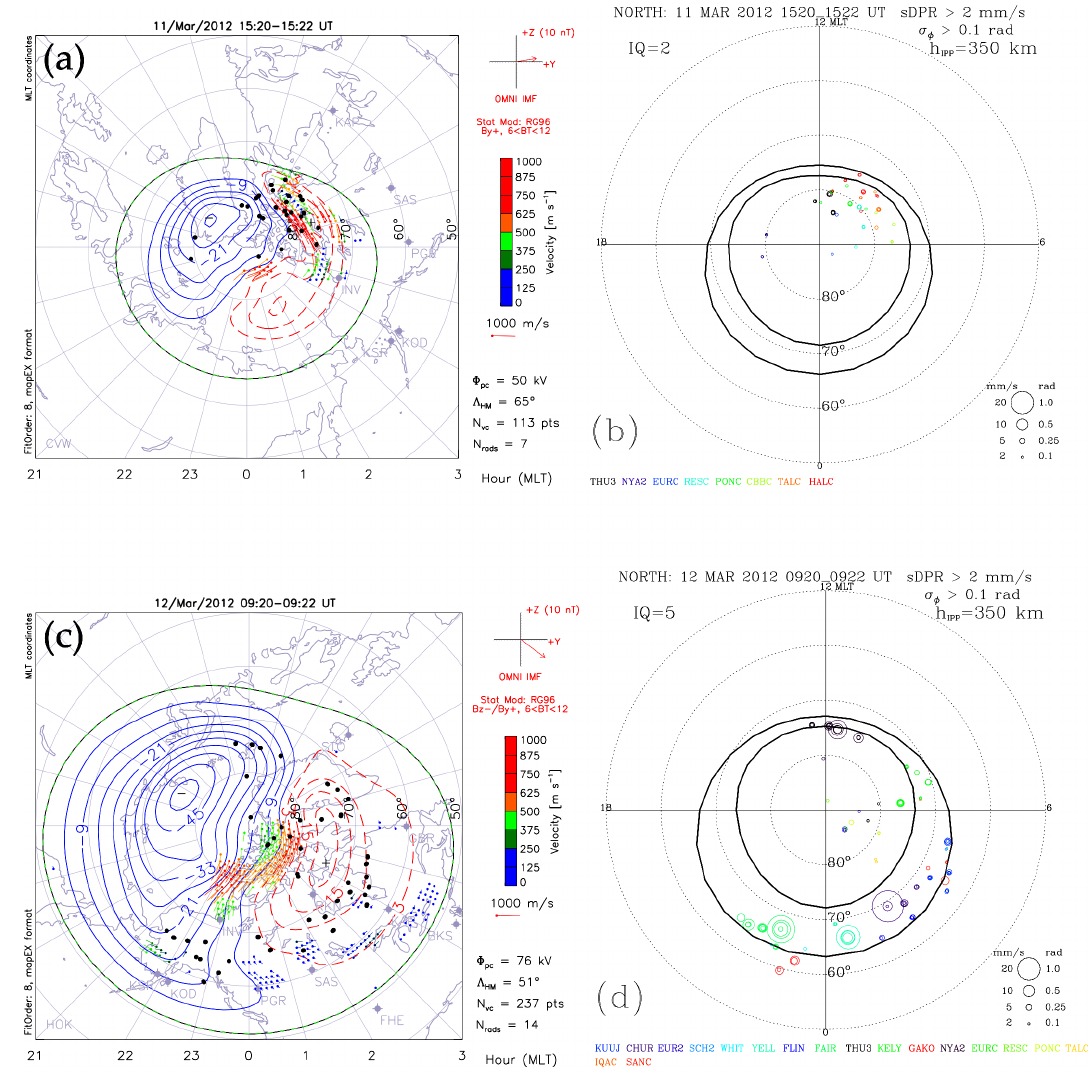
Figure 13. (a, c) Event S3: SuperDARN convection and potential maps on 11 and 12 March. The IPPs for PRNs with σ (cid:56) >0.1rad or sDPR>2mms − 1 are superposed as black dots. (b, d) The IPPs are shown as circles that are scaled proportionally to σ (cid:56) and sDPR